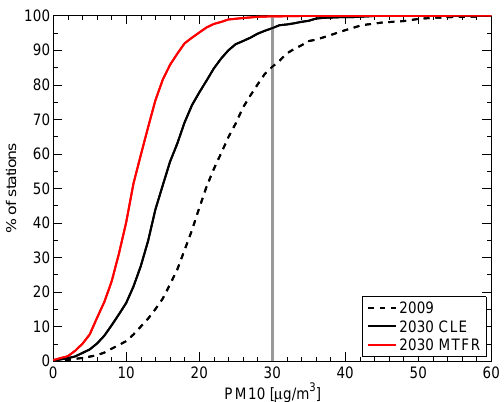
Figure 10. Cumulative distribution of PM 10 concentrations mod- elled at all stations covered in GAINS, for the base year 2009 and scenario year 2030, assuming either current legislation (CLE) or maximum technically feasible emission reductions (MTFR). The equivalent annual mean limit value of 30µgm − 3 is indicated as grey line. Natural contributions are not